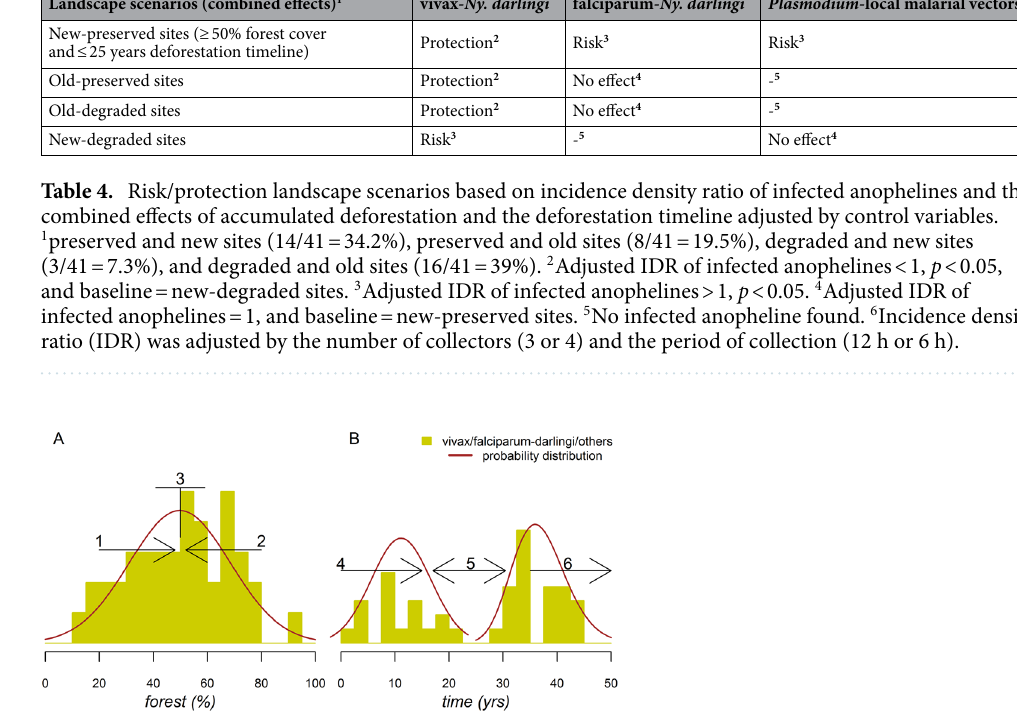
Figure 3. Pathogenic site frequency with forest cover and time. ( A ) Maximum frequency in sites having an intermediate percentage of forest cover (= 50%; Gaussian distribution; mean = 49.8, sd = 18.7; p < 0.001). ( B ) Bimodal presence with two deforestation timeline peaks, one peak at (1) 11 years (Gaussian distribution; mean = 11.1, sd = 5.5; p < 0.001) and a second peak at (2) 37 years after starting the deforestation process (log- normal distribution; meanlog = 3.6, sdlog = 0.13; p < 0.001). The two deforestation timeline distributions were significantly different (t = 15, df = 32, p < 0.001). Underlying mechanisms of malaria risk according to forest cover and time: 1, forest conservation 42 ; 2, deforestation 33 ; 3, the forest fringe hypothesis 9 and the FMH 10,17 ; 4, the FMH 10,17 ; 5, malaria-deforestation bidirectional effects 2 and 6, a rebound in malaria transmission 2,10,17